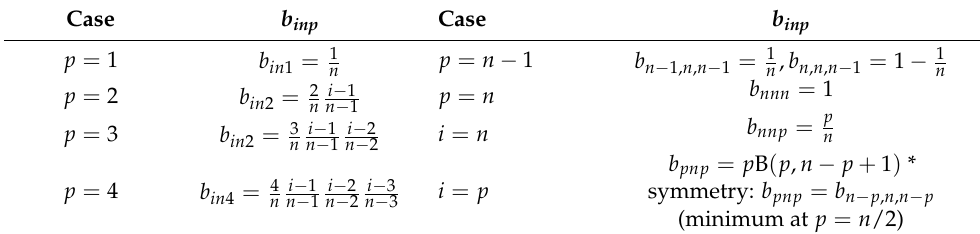
Table 1. Special cases of K-moment estimator coefficients (adapted from [6], p. 194). Case b inp Case b inp p = 1 b in 1 = 1